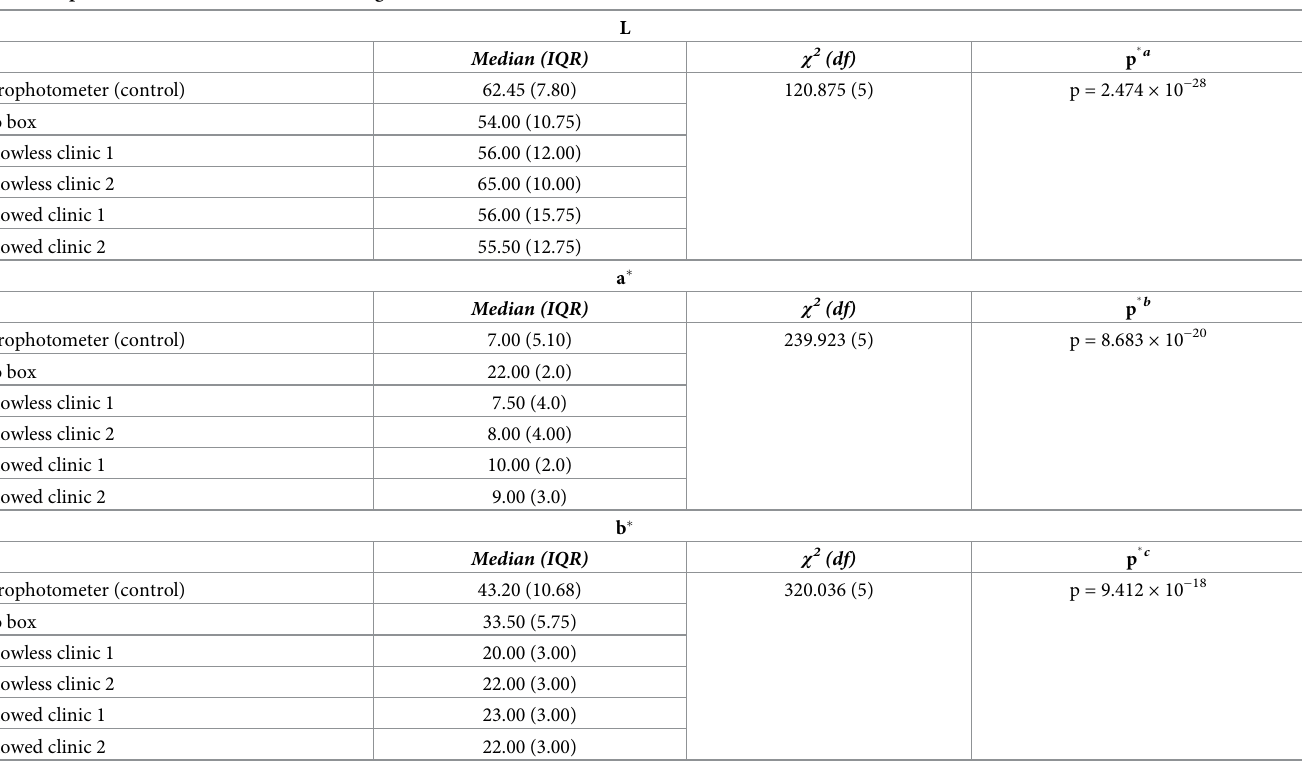
Table 2. Comparison of L, a � and b � values for images with camera white balance